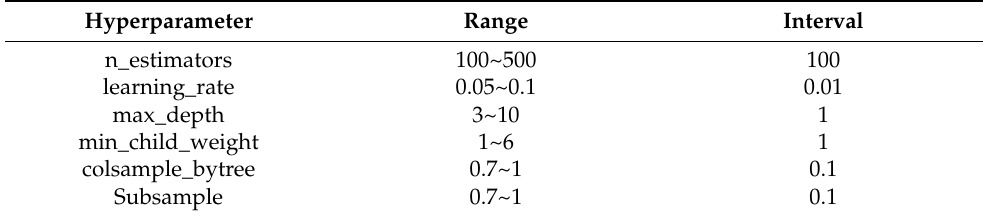
Table 1. Hyperparameters search range in the GridSearchCV.